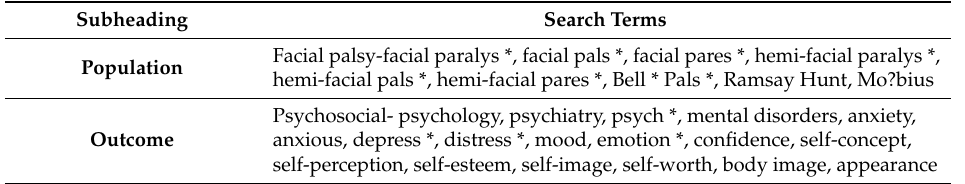
Figure 1. Flowchart of study selection. Table 1. Search terms used in the literature search.